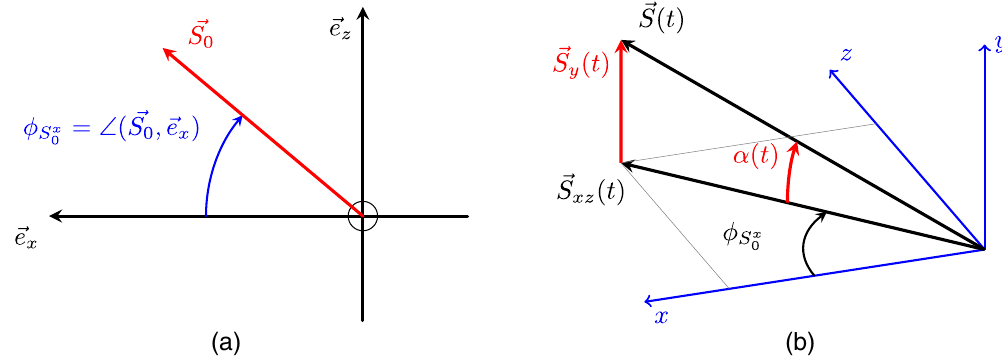
⃗ ð t Þ and the out-of-plane S y